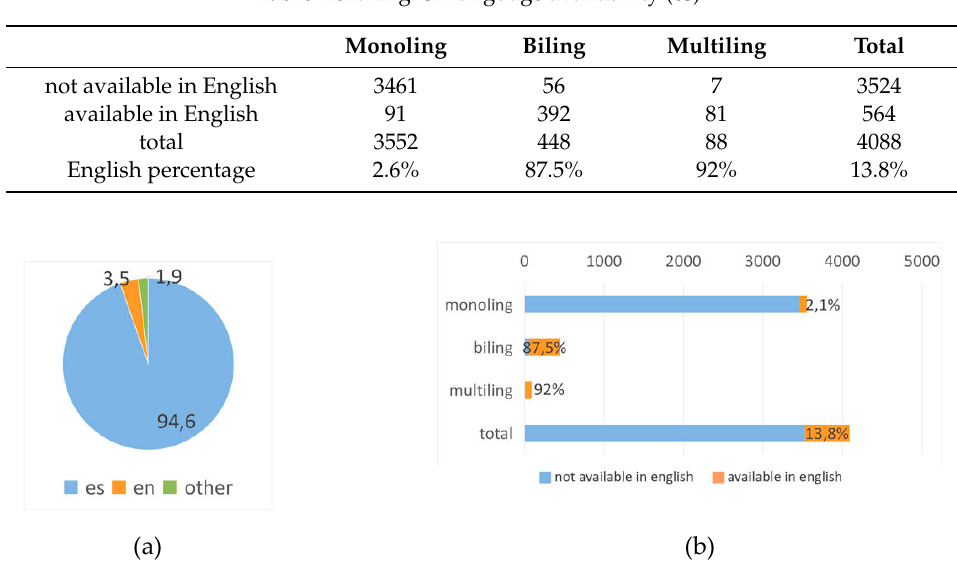
(b) Figure A25. Visualization of the results for domain si. ( a ) Primary languages pie chart and ( b ) English